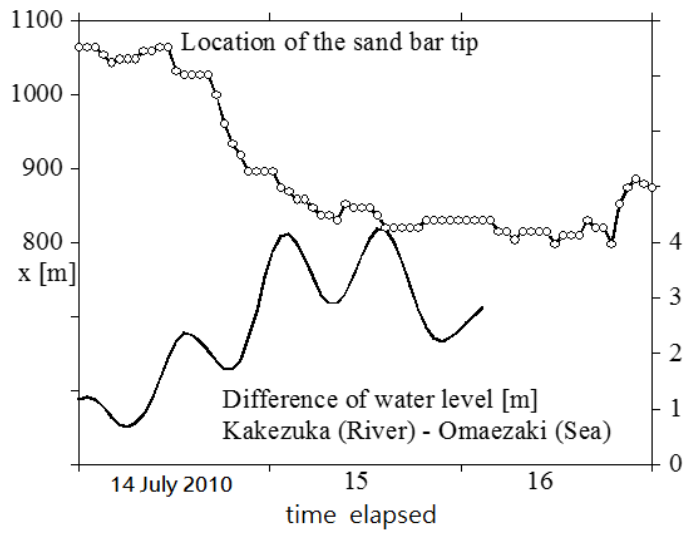
Figure 4. Variation of the east-west location of the tip of the sand bar, and the water level difference between the river and the sea. x denotes east-west coordinate shown in Figure 1b.